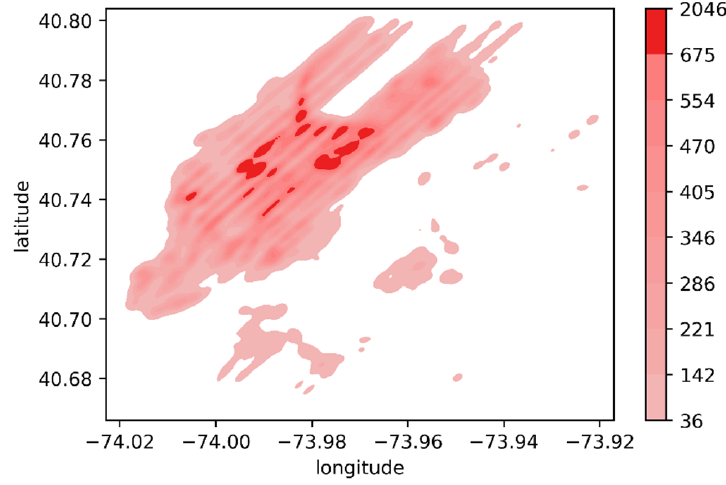
Figure 5. The spatial kernel density distribution of New York taxi demand in April 2016.